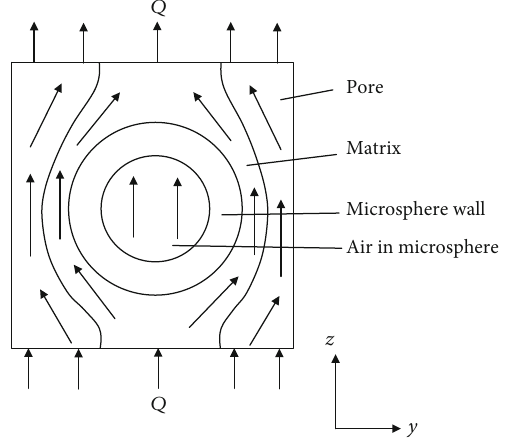
Figure 4: Heat transfer diagram of pores and